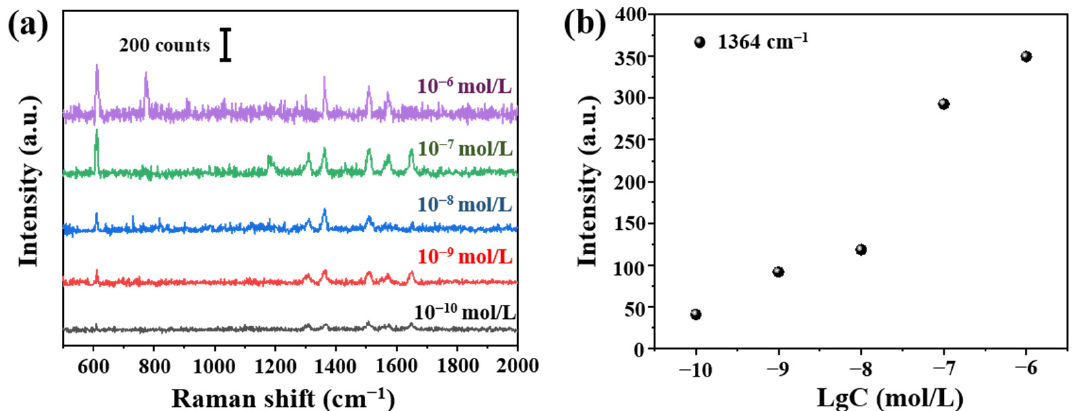
Figure 9. ( a ) Raman spectra from 10 − 6 to 10 − 10 mol/L R6G and ( b ) the relationship between Raman intensity at 1364 cm − 1 and Lg (R6G